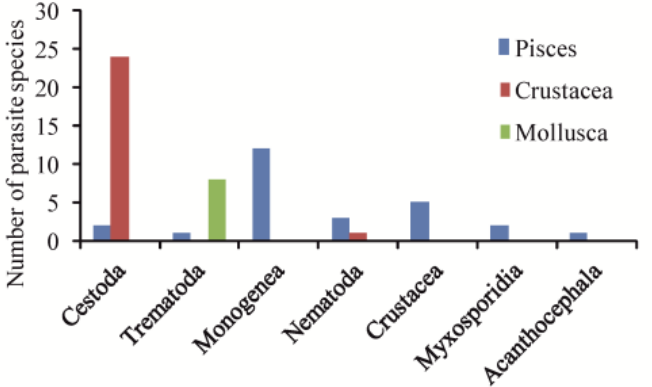
Figure 2. Parasite richness (number of species and unidentified forms) among host taxa in hyper- saline waters.